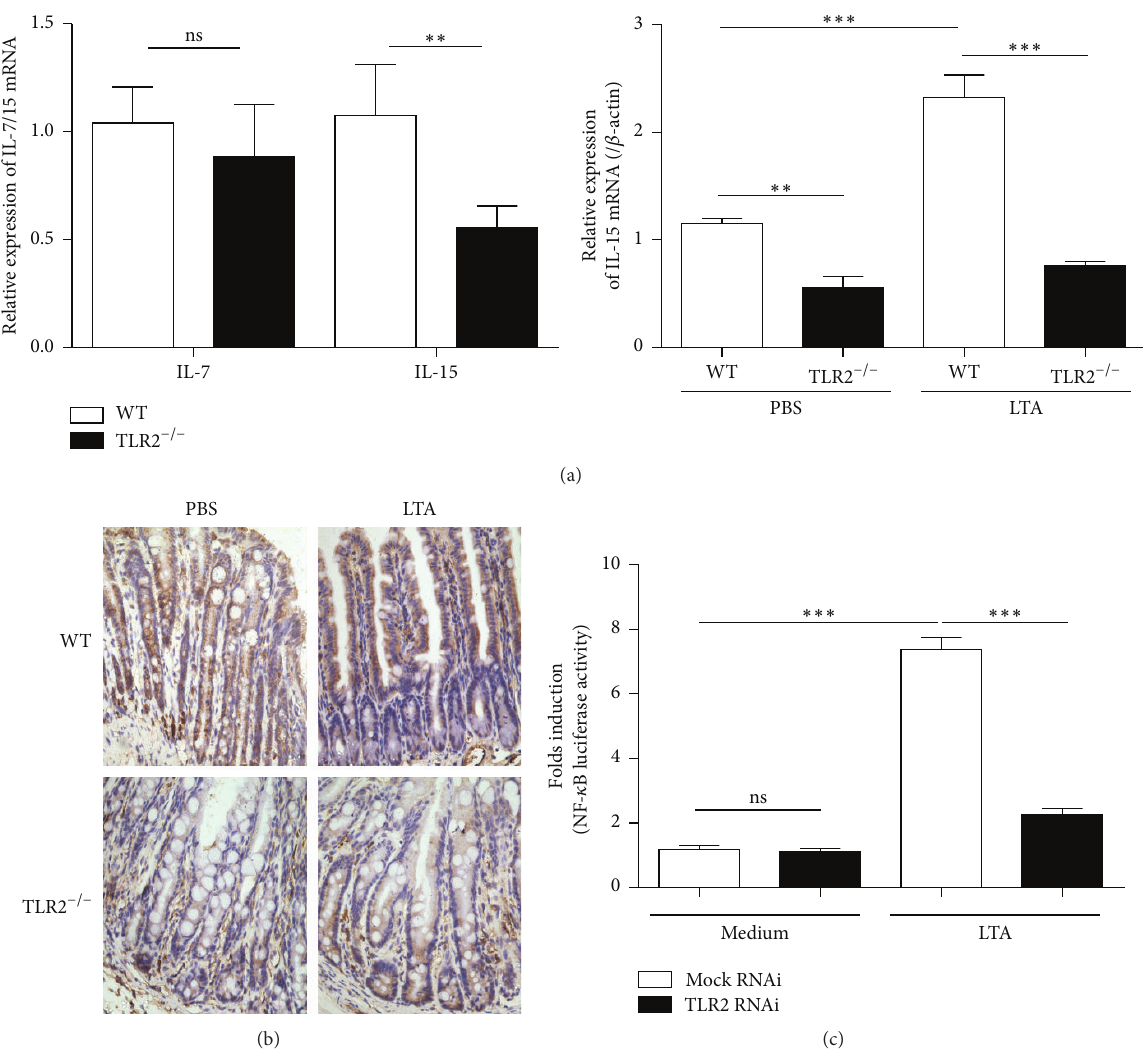
Figure 4: The effect of TLR2 knockout (down) on IL-15 expression in intestinal epithelial cells. (a) RT-PCR analysis of IL-7 and IL-15 expression in the jejunum sample. RNA was prepared from the samples of the TLR2 −/− mice and the wild-type mice. (b) Immunohistochemistry with IL-15 antibody on sections of small intestine from wild-type mice + PBS, wild-type mice + lipoteichoic acid (LTA), TLR2 −/− mice + PBS, and TLR2 −/− mice + LTA. Images are 400x. (c) SW480 cells were transfected with TLR2-siRNA or Mock and TK-RL and pBIIx-luc. At 24h after transfection, the cells were stimulated with the indicated concentrations of LTA, and then both firefly and Renilla luciferase activities were determined using a dual-luciferase assay. The experiments were repeated three times, and all of the data were expressed as the mean ± SD. ∗∗ 𝑃 < 0.01 ; ∗∗∗ 𝑃 < 0.001